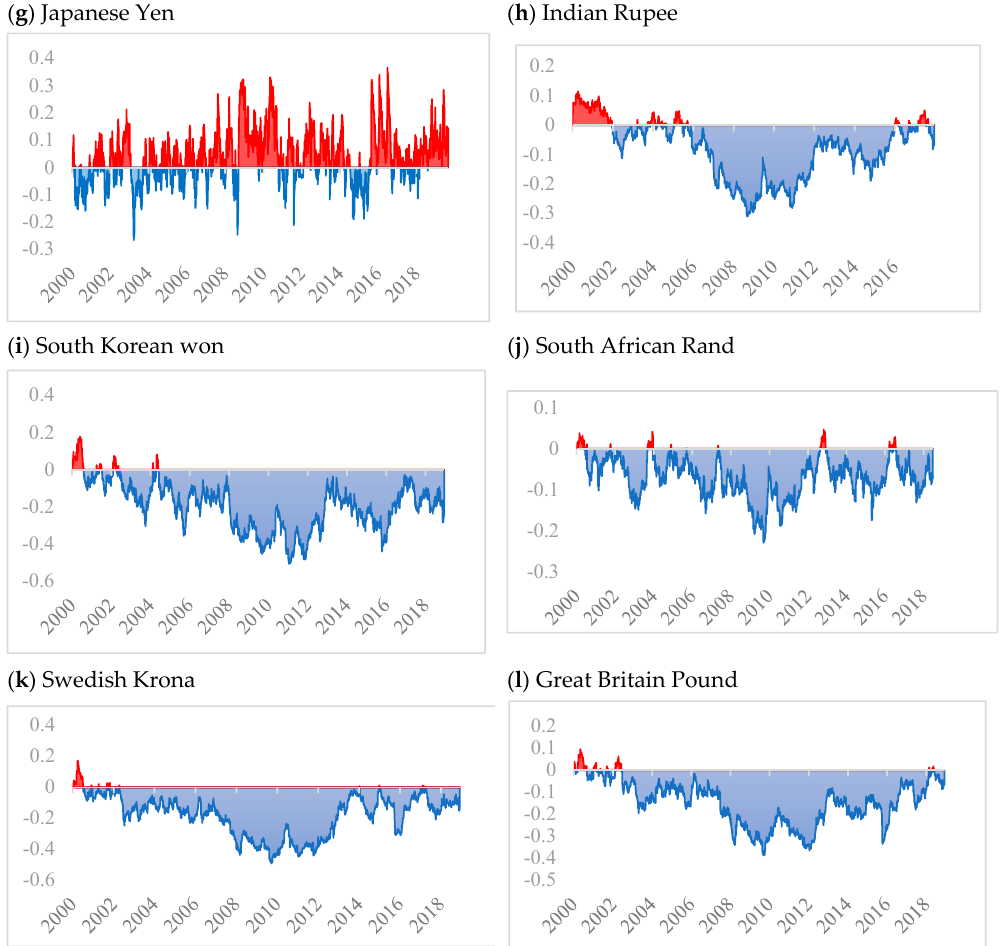
Figure 1. Time-varying dynamic correlations between the returns of major currencies and the West Texas Intermediate (WTI) crude oil returns using ADCC-GARCH model estimations.